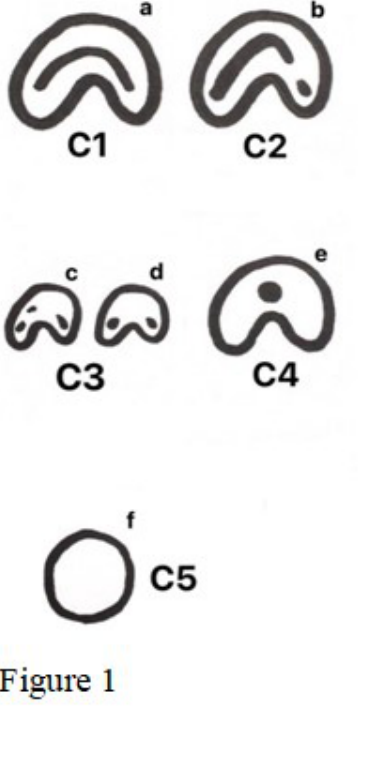
F ig. 2 - Measurement of angles for the type C2. Angle ꞵ is more than 60° . (A and B) - ends of one canal cross - sec�on; (C and D) - ends of the other canal cross - sec�on; M - middle point of line AD; α - angle between line AM and line BM; ꞵ - angle between line CM and line DM [35]. Diagrams drawn according to the paper by Fan et al. [35].